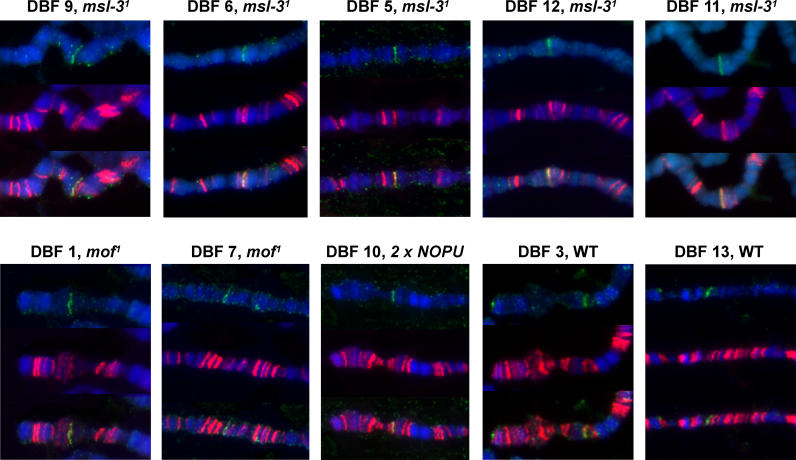
The Endogenous Loci of the DCC Binding Fragments Overlap with MSL1 In VivoImmuno-FISH experiments using the identified DBFs as probes (FISH signals in green) and staining with anti-MSL1 antibodies to visualize DCC binding (in red). Each panel consists of images of the FISH signal (top), the anti-MSL1 signal (middle), and the merge (bottom). The FISH signals from DBF9, DBF6, DBF5, and DBF12 overlap with the anti-MSL1 signals in the msl-31 mutant background (w/w; msl-31, [w+ Hsp83 MSL2]). DBF11 overlaps partially with MSL1 staining in this background. DBF1 and DBF7 overlap with weak anti-MSL signals in the mof1 mutant background (mof1/mof1; +; [w+ Hsp83 MSL2]/+). FISH signals from the endogenous loci of DBF3, DBF10, and DBF13 do not overlap with MSL1 staining in either the msl-31or mof1 background. However, DBF10 does overlap with MSL1 staining in females carrying two copies of the NOPU insert (2 × NOPU, Figure1), whereas DBF3 and DBF13 overlap with MSL staining in wild-type males (WT).